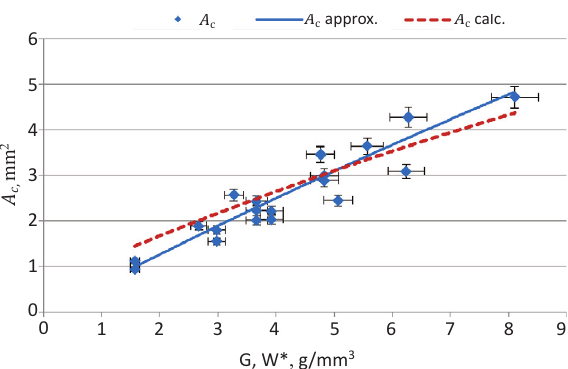
Fig. 10. Effect of parameter G on the surface of the cladding square 𝐴 𝑐